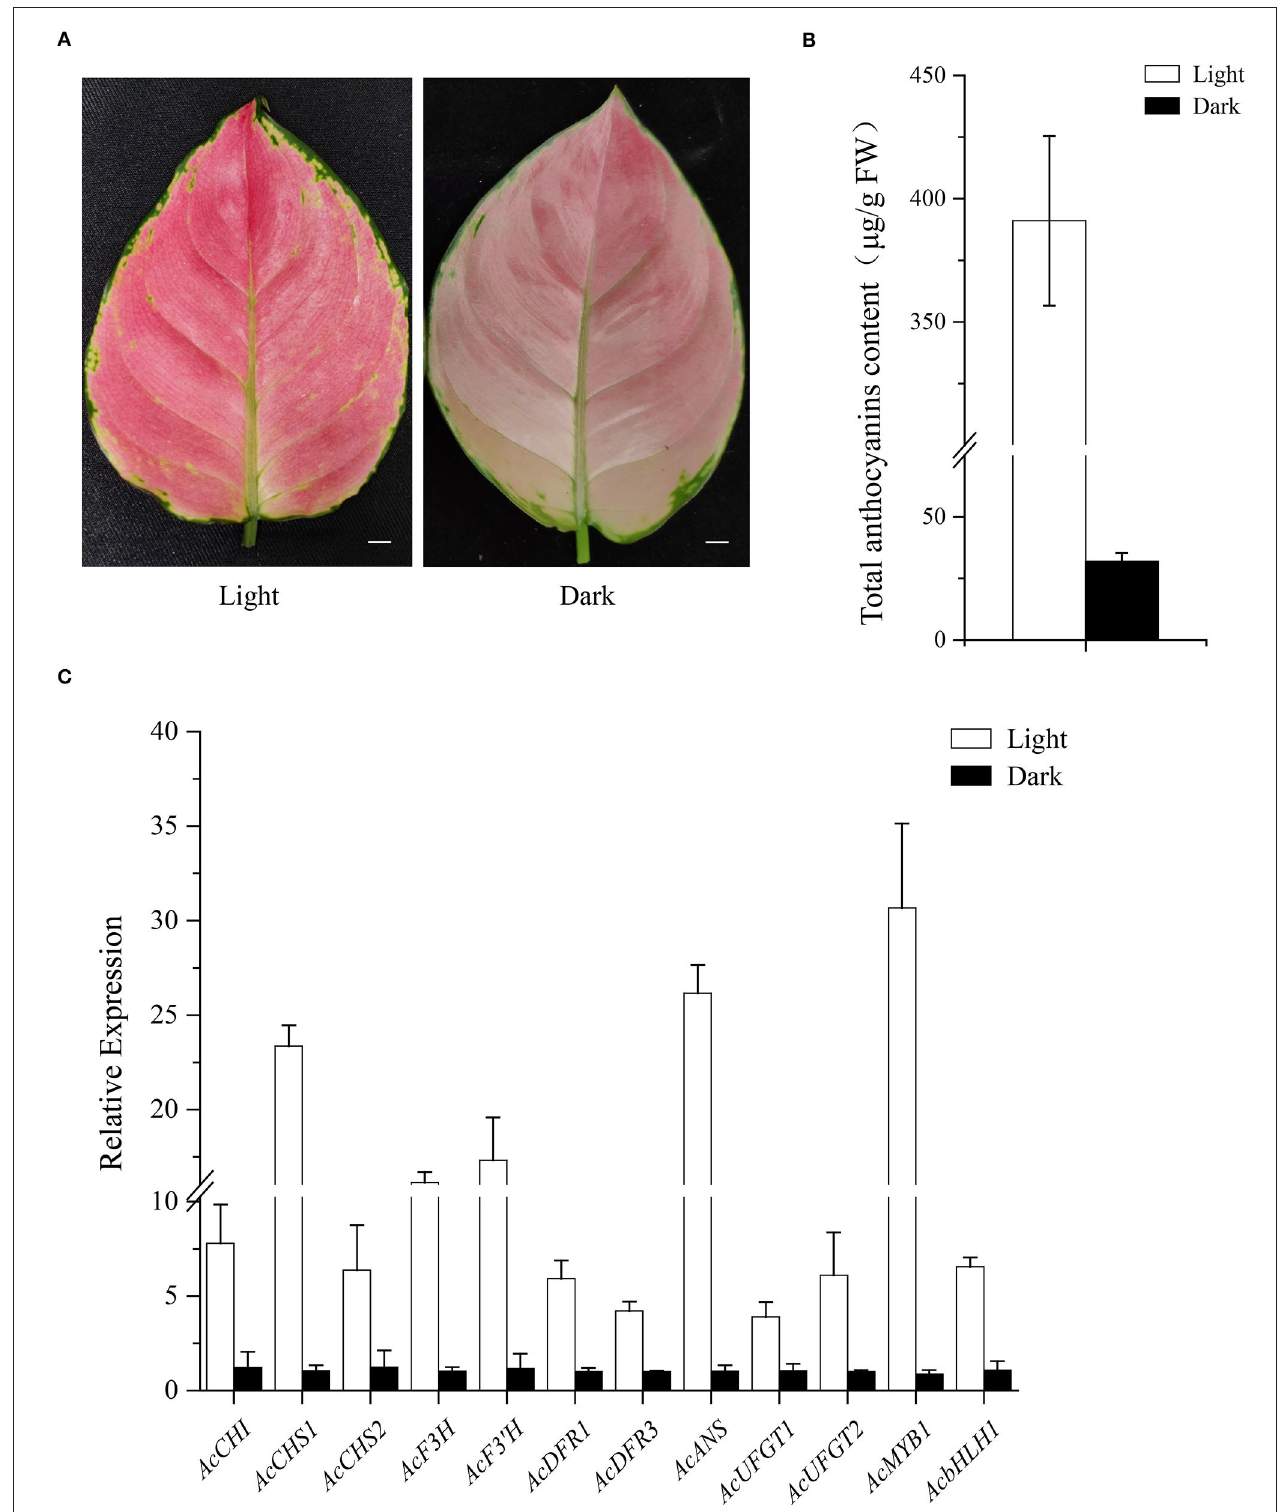
FIGURE 9 | Influence of light on leaf color. (A) Leaf phenotype after 5 days light (left) or dark (right) treatment. (B) . Anthocyanin content of light and dark treatment. (C) Expression analysis of AcMYB 1, AcbHLH1, and 10 structural genes of the anthocyanin pathway was determined by qRT-PCR assay with AcEF-1 α as a reference gene. Bar: